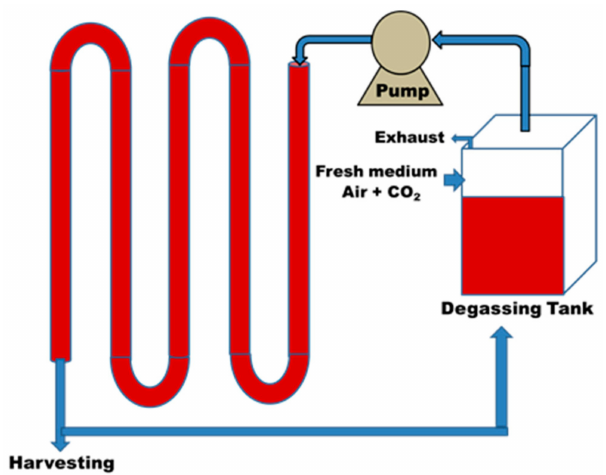
Figure 4. Schematic diagram showing simple tubular photobioreactor that can be operated both vertically or horizontally with continuous supply of nutrients and mixing of cells through pump, with CO 2 supply and exhaustion of produced